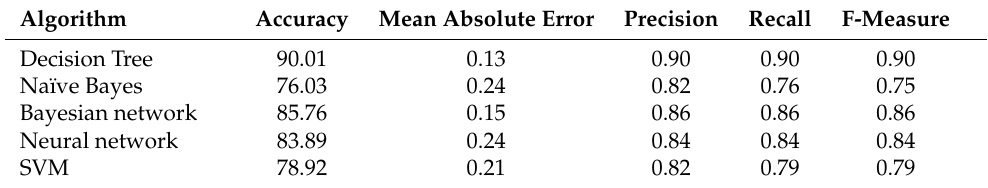
Table 10. Case study 2 results for PCA dimension reduction approach using